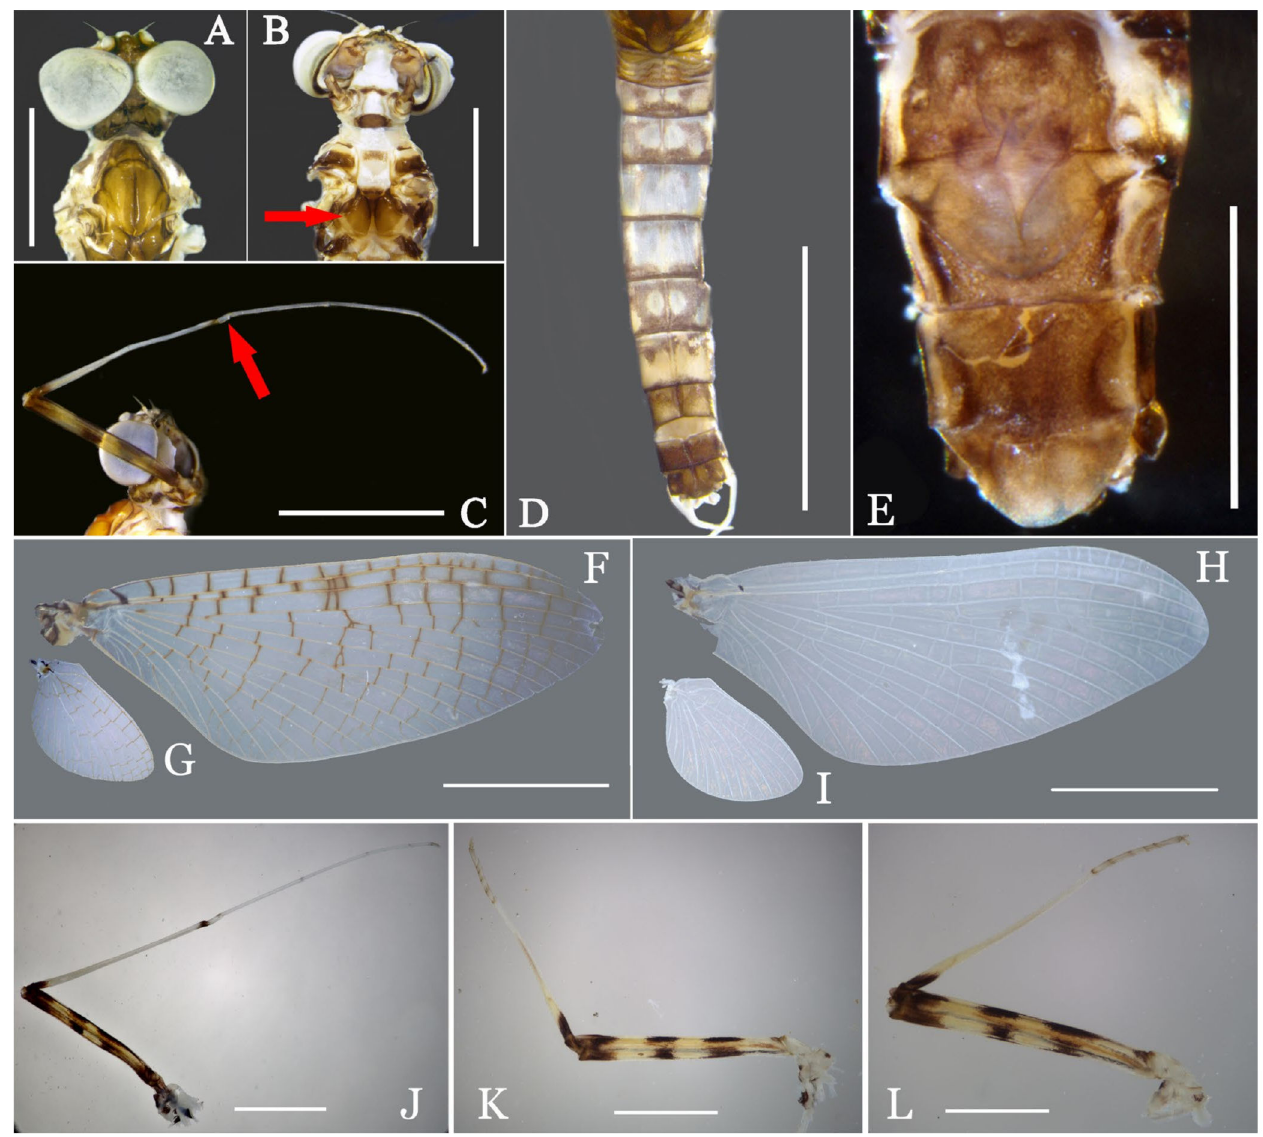
Figure 7. Adult structures of Maculogenia ngi (digital photos): ( A ) Transverse suture of mesonotum; ( B ) medial depression of furcasternum (shown in red arrow); ( C ) foreleg (shown in red arrow); ( D ) abdominal terga; ( E ) subanal plate of female imago; ( F ) forewing of female imago; ( G ) hindwing of female imago; ( H ) forewing of male imago; ( I ) hindwing of male imago; ( J ) foreleg of male imago; ( K ) midleg of male imago; ( L ) hindleg of male imago. Scale bars: ( A – C ) = 2.0 mm; ( D ) = 3.0 mm; ( E ) = 1.5 mm; ( F – I ) = 3.0 mm; ( J – L ) = 1.0